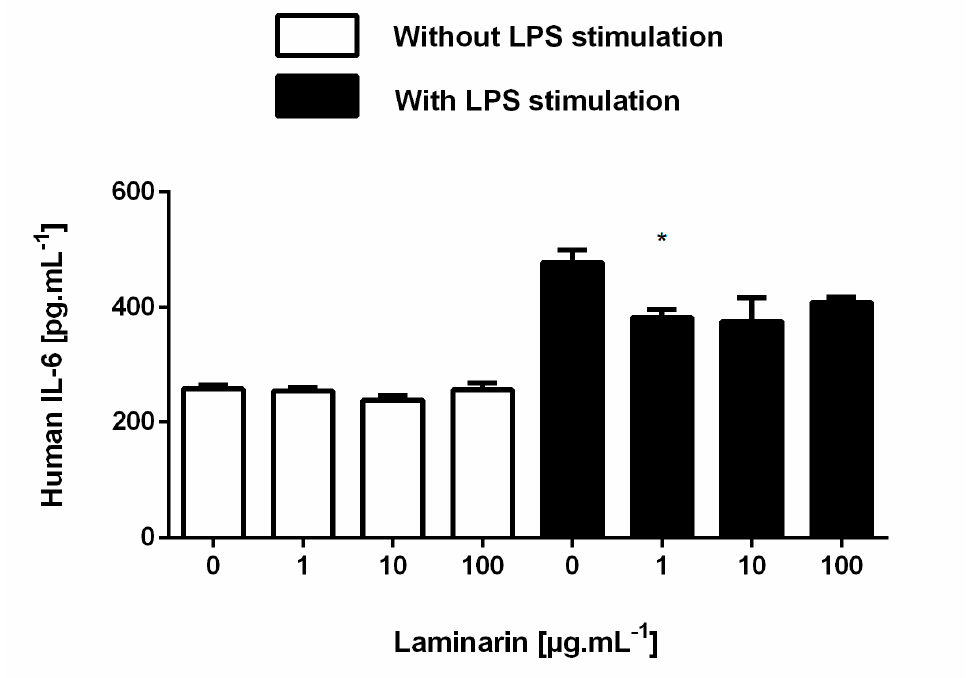
Figure A5. Quantitative analysis of IL-6 cytokine with an ELISA kit. HaCaT cells were stimulate with 1, 10 and 100 µg.mL − 1 laminarin for 48 h in absence or in presence of LPS at 10 µg.mL − 1 . An ELISA assay was performed to quantify the level of IL-6 cytokine secretion on the cell culture medium supernatant. Data are expressed as mean ± SD of two independent experiments. * p ≤ 0.05 compared with 0 µg.mL − 1 (control group).